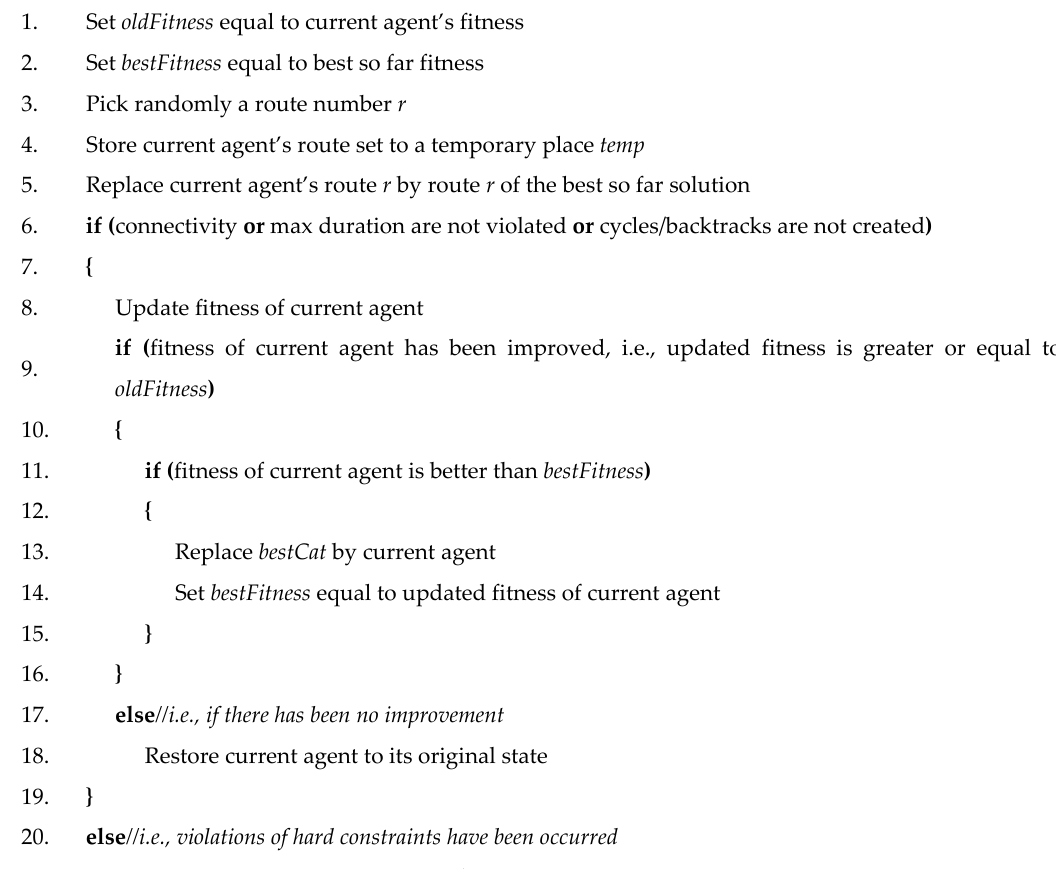
Figure 3. Pseudocode of the seeking mode process.